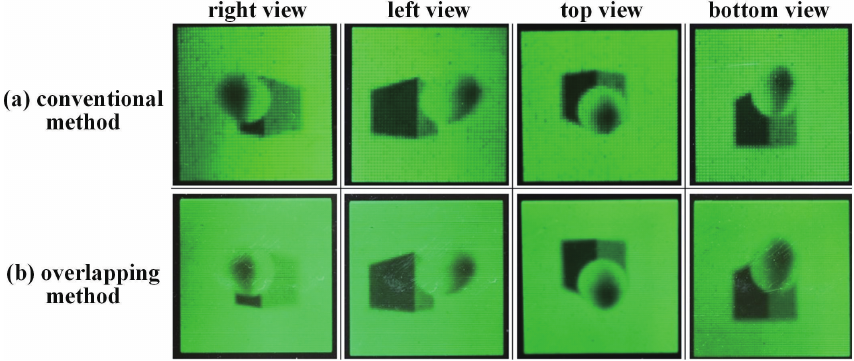
Figure 11. Perspective images captured from different viewing points by Hong’s group: ( a ) conventional method and ( b ) overlapping method. (Reprinted with permission from ref [56],